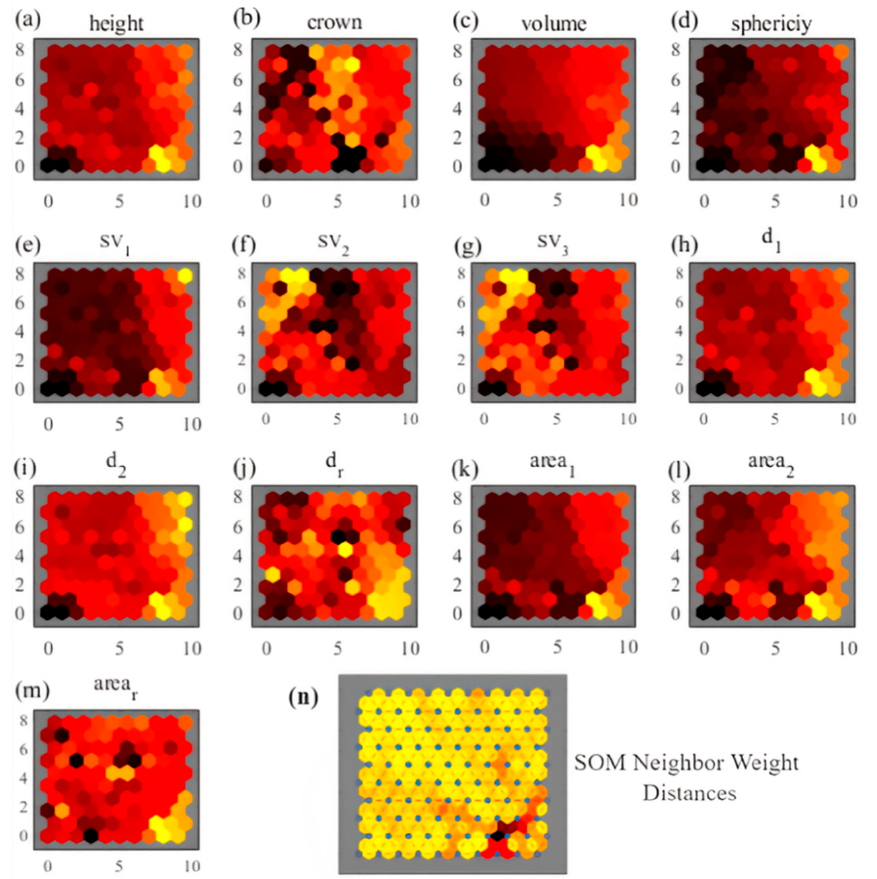
Figure 13. Feature space distribution of SOM for under-segmented and over-segmented sample classification. ( a – m ) Relative distribution of each of the thirteen feature parameters in the feature space; ( n ) Distribution of all feature vectors in the feature space.